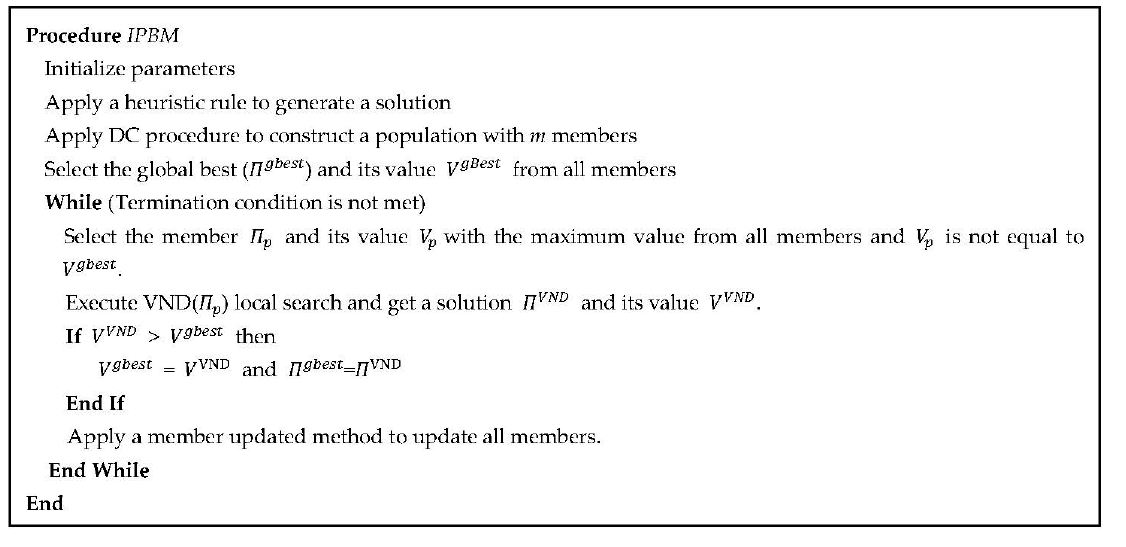
Figure 1. Procedure of the proposed IPBM.